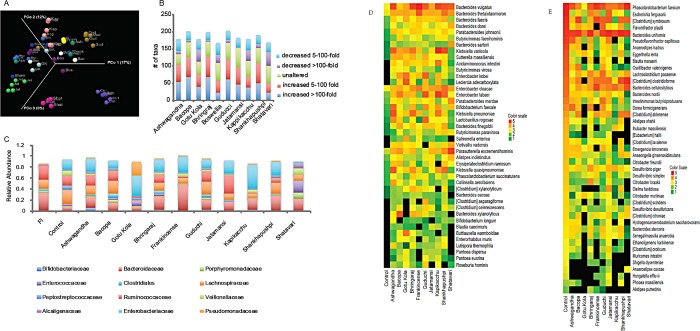
A. PCoA of nervine herbs. Bray-Curtis PCoA β-diversity plots of communities observed in Ctrl = control, Shat = Shatavari, Jat = Jatamansi, GK = Gotu Kola, Ash = Ashwagandha, Bos = Boswellia = Frankincense, Bac = Bacopa, Shank = Shankhapushpi, Gud = Guduchi, Kap = Kapikacchu, Bhr = Bhringaraj cultures and the uncultured FI = fecal inoculum. B. Modulatory capacity of nervine medicinal herbs. Average fold change of taxa comparing herb-supplemented to control cultures. Zeros were replaced with e-6 to permit minimum fold-change values to be calculated. C. Medicinal herbs induce distinct microbial communities. Average relative abundance of bacterial families generated in herb-supplemented cultures. D. Taxa displaying high herb responsiveness. Taxa displaying increased average abundance >5-fold compared to controls in 8 or more herb-supplemented cultures. Relative abundance values were multiplied by 1X106 to convert all values to >1. These values were log10 transformed and depicted in the heatmap. E. Taxa displaying low herb responsiveness. Taxa displaying decreased average abundance >5-fold compared to controls in all herb-supplemented cultures. Relative abundance values were multiplied by 1X106 to convert all values to >1. These values were log10 transformed and depicted in the heatmap.